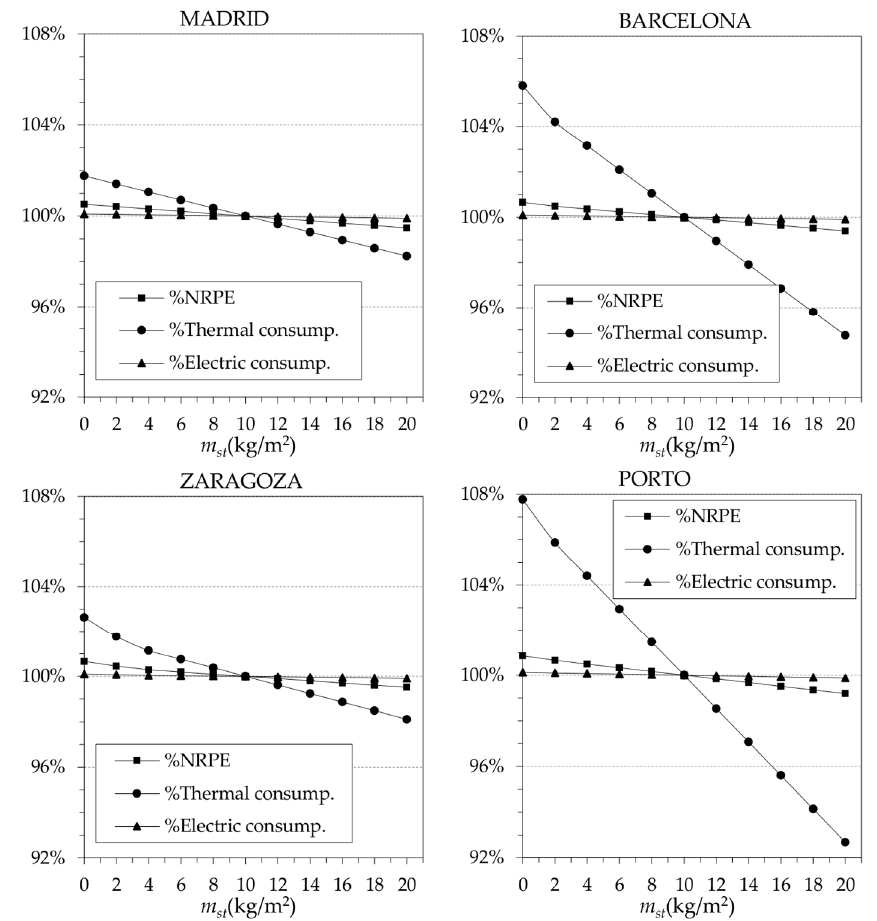
Figure 8. Effect of storage capacity per unit of habitable surface area ( m st ) in the relative annual total thermal consumption, total electrical consumption and nonrenewable primary energy with respect to a base case with m st = 10 kg/m 2 .